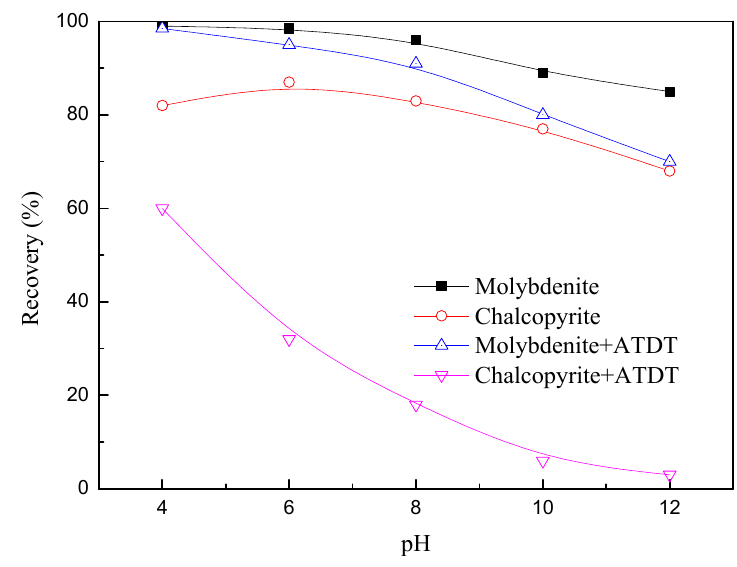
Figure 2. The recovery of chalcopyrite and molybdenite as a function of pH by Kerosene (200 mg/L) and MIBC (80 mg/L) with or without ATDT (4 × 10 − 4 mol/L).